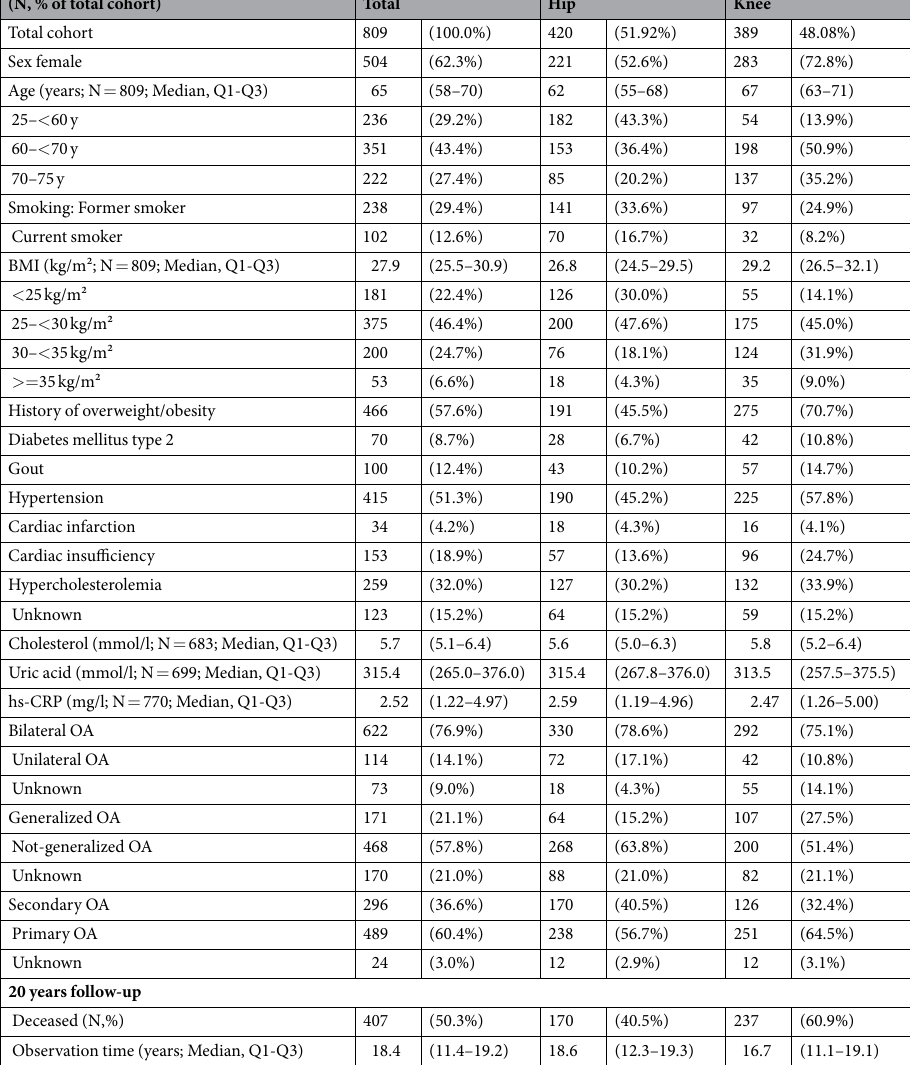
Table 1. Patient characteristics at baseline. N number of patients; Q1 first quartile; Q3 third